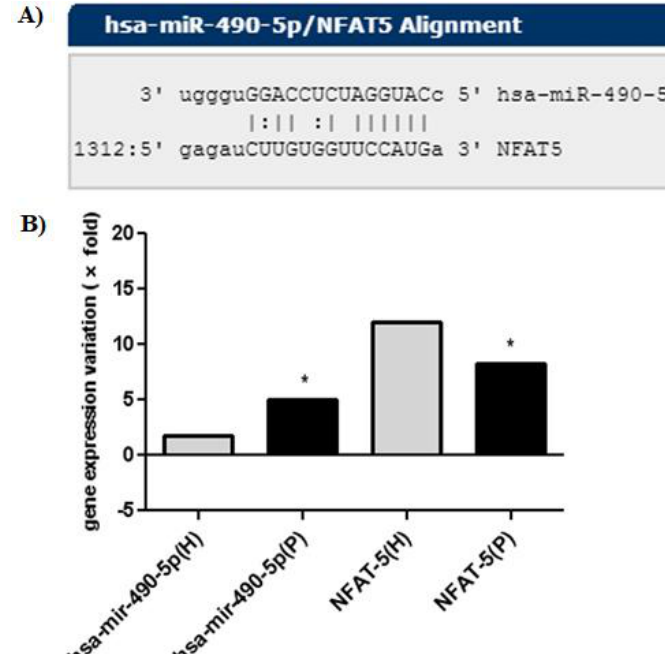
Fig. 3. MiR-490-5p targets NFAT5 and influences NFAT5 downstream factors directly: A) NFAT-5 mRNA is supposed to be a target of miR-490-5p with the binding sequence UCCAUG; B) Gene expression of hsa-miR- 490-5p and NFAT5 were changed in PBMC. For patient was used (P) and for the control group was used (H). Expression of NFAT5 in breast cancer patients was lower than the control group, and this was significant. In addition, changes in the expression of hsa-miR-490-5p in the patients compared to the control group, which was significant in patients and expression was high in